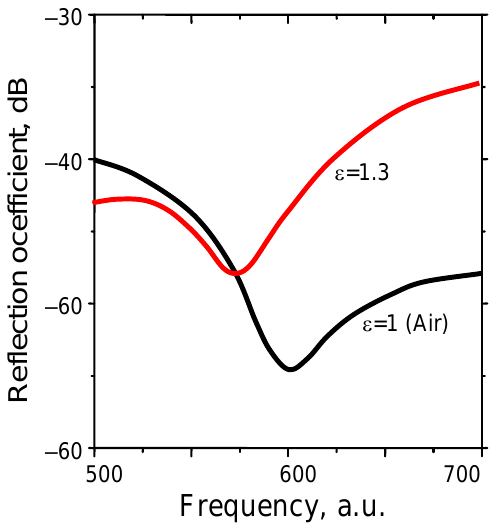
Figure 15. Reflection from a metal-dielectric-metal symmetric freestanding fishnet MM with circular holes in the case of PEC without adsorbed dielectric (surrounding  = 1.0) and with an adlayer (  =